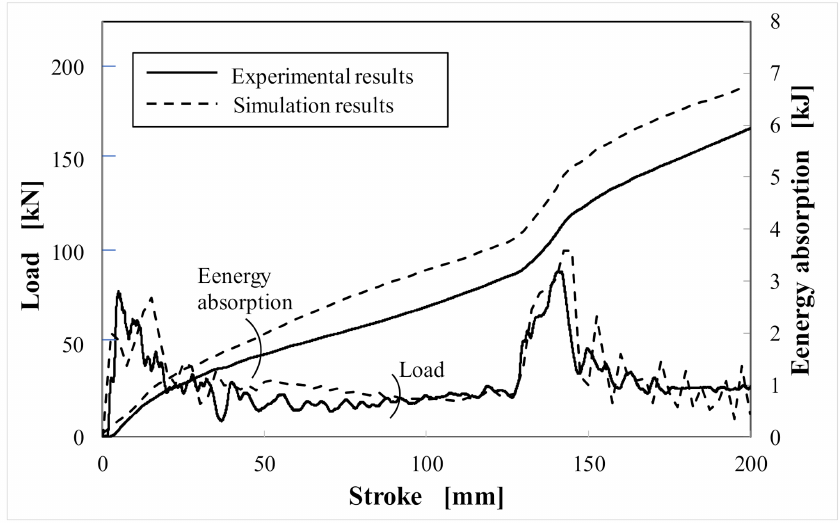
Figure 15. Relationship between load and stroke of partially quenched product in axial crash